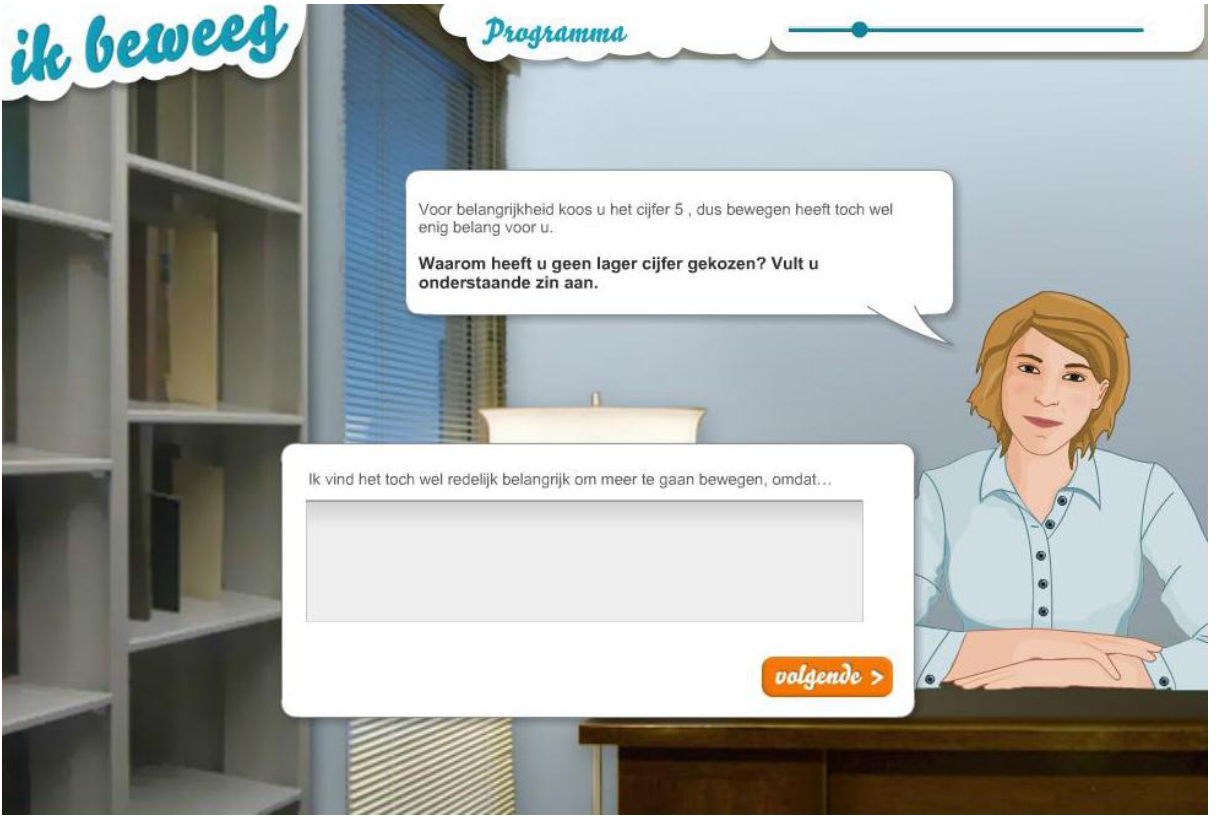
Figure 2. Screenshot of the AVATAR